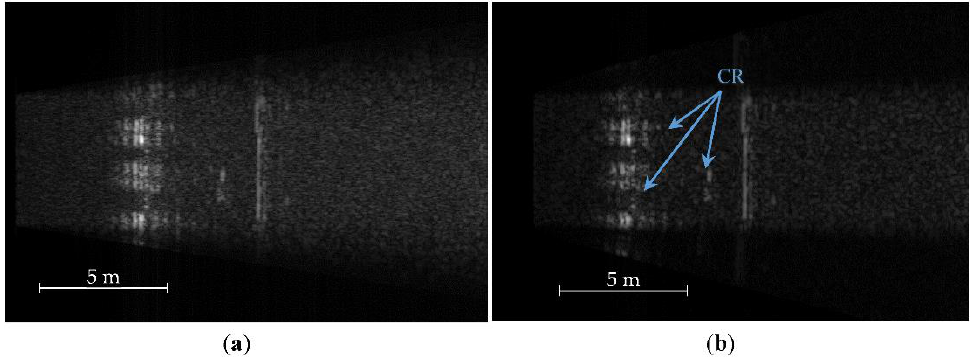
Figure 6. Bistatic GB-SAR focused image by ( a ) RDA and ( b ) BPA for B = 0.5 m.